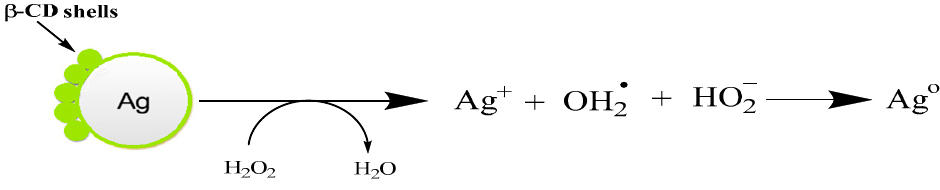
Figure 3. Schematic representation of the mechanism of β CD-AgNPs reaction with hydrogen peroxide. To measure the level of H 2 O 2 in patients’ urine, calibration curves are established in mM, µ M and nM concentration ranges, which are presented in Figure 4a–c, respectively.